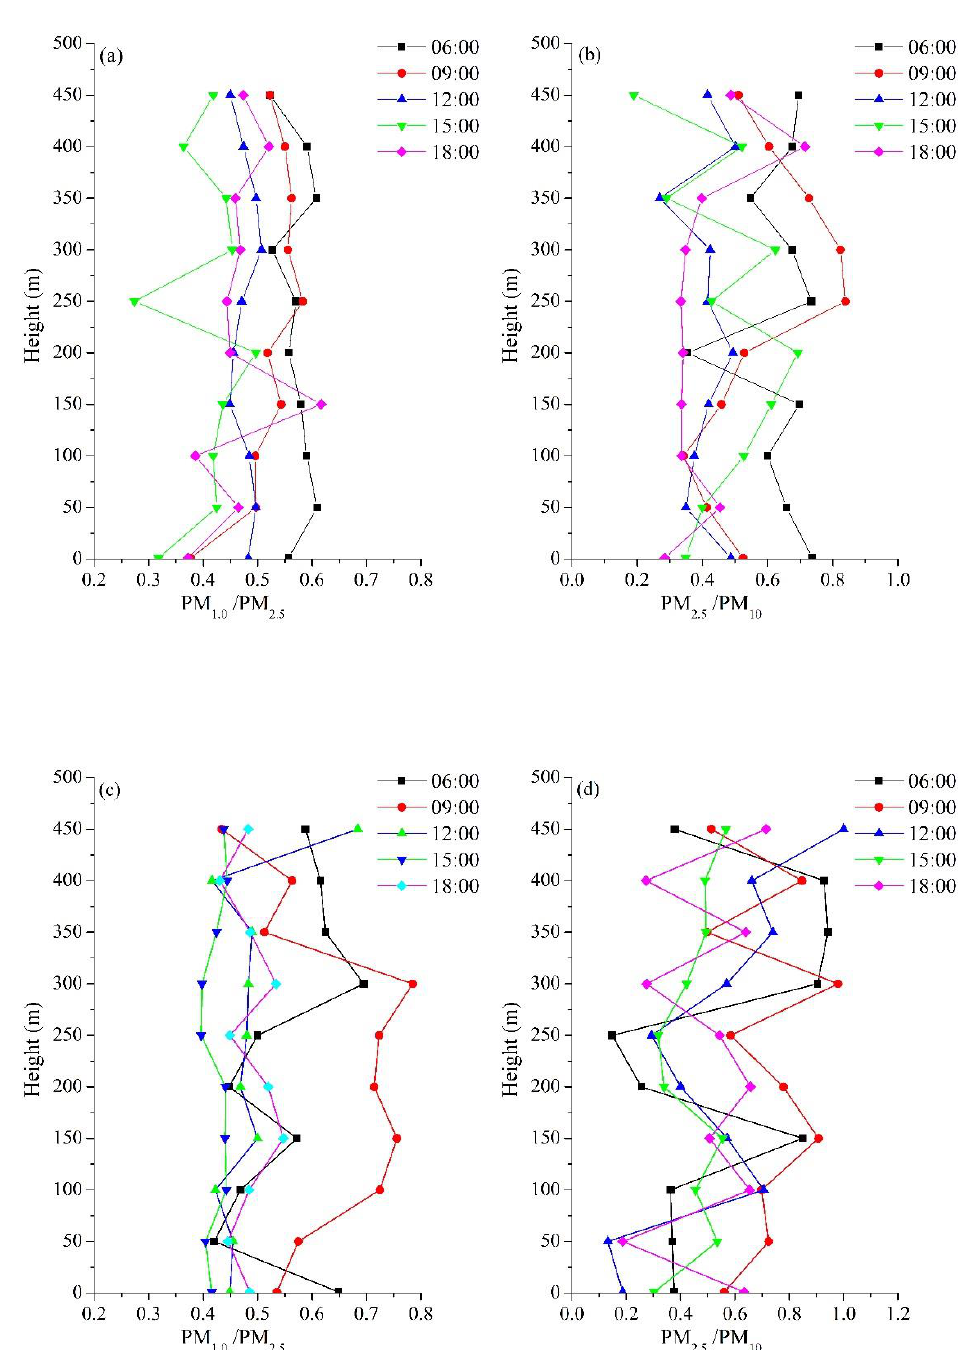
study Figure 11. Ratios of PM 1.0 /PM 2.5 and PM 2.5 /PM 10 in ( a , b ) Tazhong and ( c , d ) Xiaotang during the study periods.